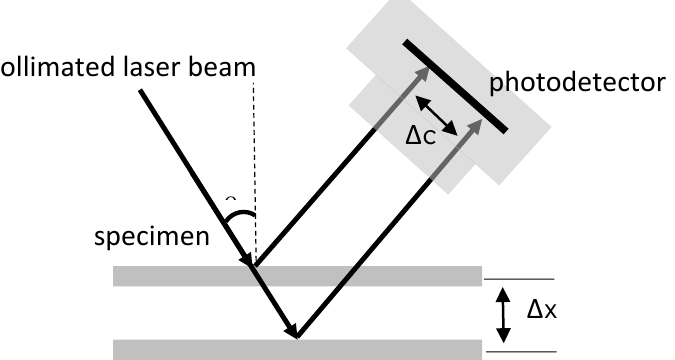
Figure 1. Illustration of optical triangulation method for measuring the displacement of specimen. A well collimated laser beam irradiates the surface of the specimen at an angle, the reflected beam is collected by a photodetector, and thus the displacement of the specimen can be estimated by the position of the imaged laser spot.